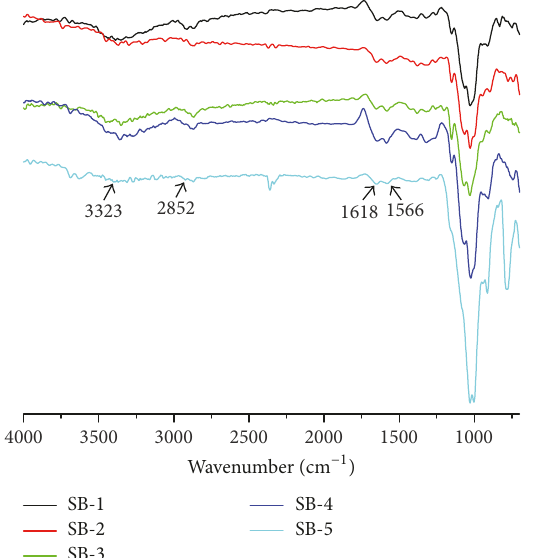
Figure 4: FTIR spectra of composites.